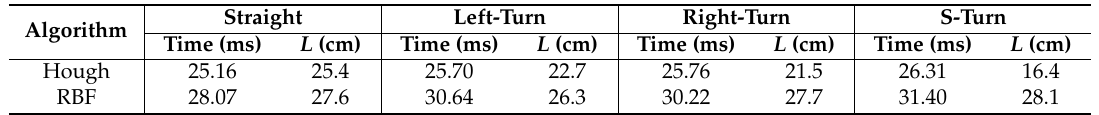
Table 2. The average search time and the minimum distance of the boundary by Hough and